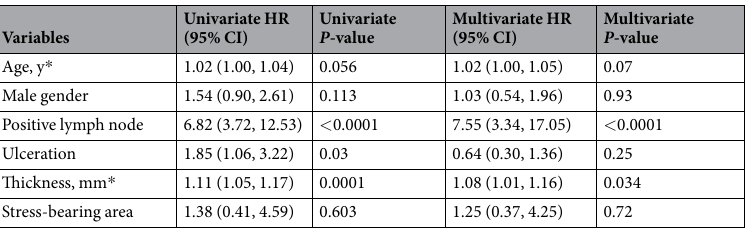
midfoot was not significantly more conductive to the generation of melanomas ( P = 0.059). Moreover, the distri- bution pattern of the melanomas was not associated with age, gender, right/left side, ulcer, mitosis, lymph node metastasis, tumor thickness, or stage (Table 1). The 5-year OS rate of the 153 melanoma patients was 57.8%. When stratified by stress-bearing (n = 105) and non-stress-bearing (n = 9) melanomas, the 5-year OS rates of the melanoma patients were 55.8% and 65.6%, respectively. Kaplan-Meier curves revealed no significant OS, DMFS, and RFS differences between melanomas developed in stress-bearing and non-stress-bearing areas ( P = 0.6, 0.64, and 0.97, respectively, log rank test) (Fig. 1c and Supplementary Fig. S2). There was also no significant difference in OS between the rear/front of the foot group and the arch group ( P = 0.945). The results of Cox univariate and multivariate analyses of the